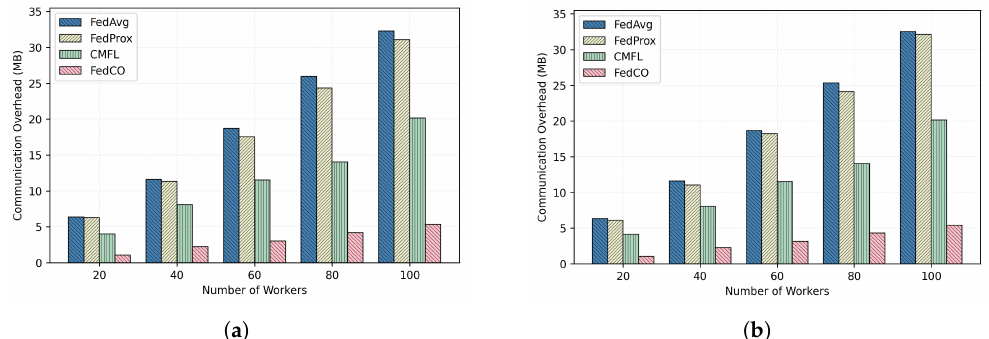
Figure 10. The communication overhead for 100 rounds for the CIFAR-10 data. The top plot presents the results produced in the case of the IID data distribution scenario, while the bottom plot depicts the results generated in the case of the Non-IID data distribution scenario. ( a ) IID. ( b ) Non-IID.